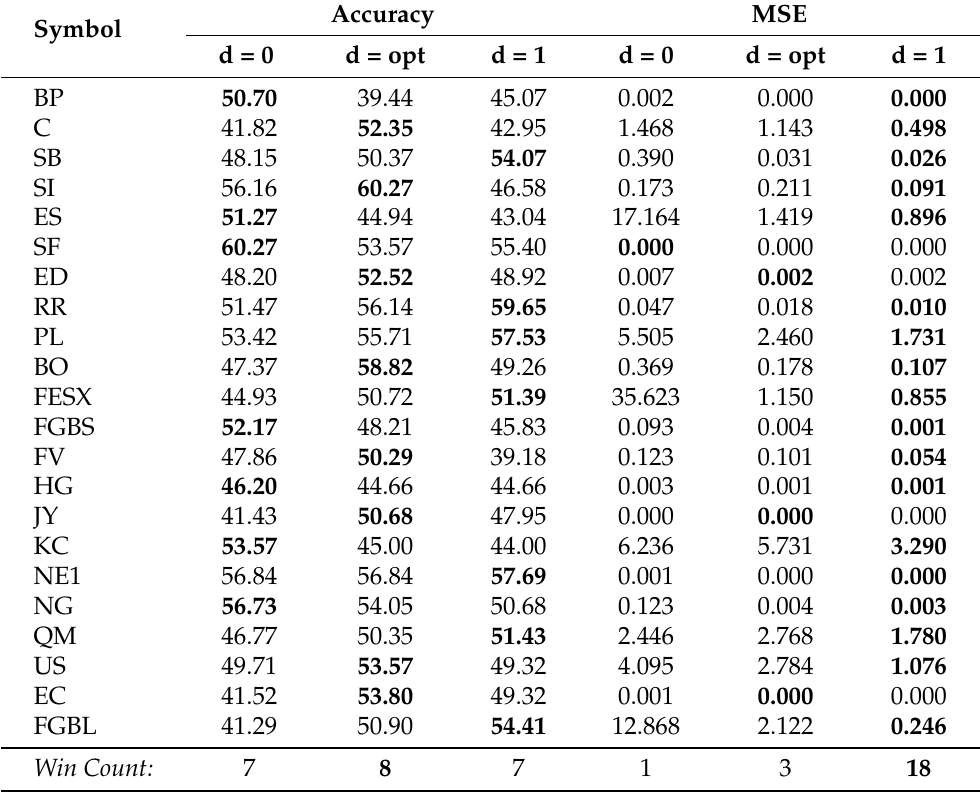
Table 7. Accuracy and MSE results of predicted